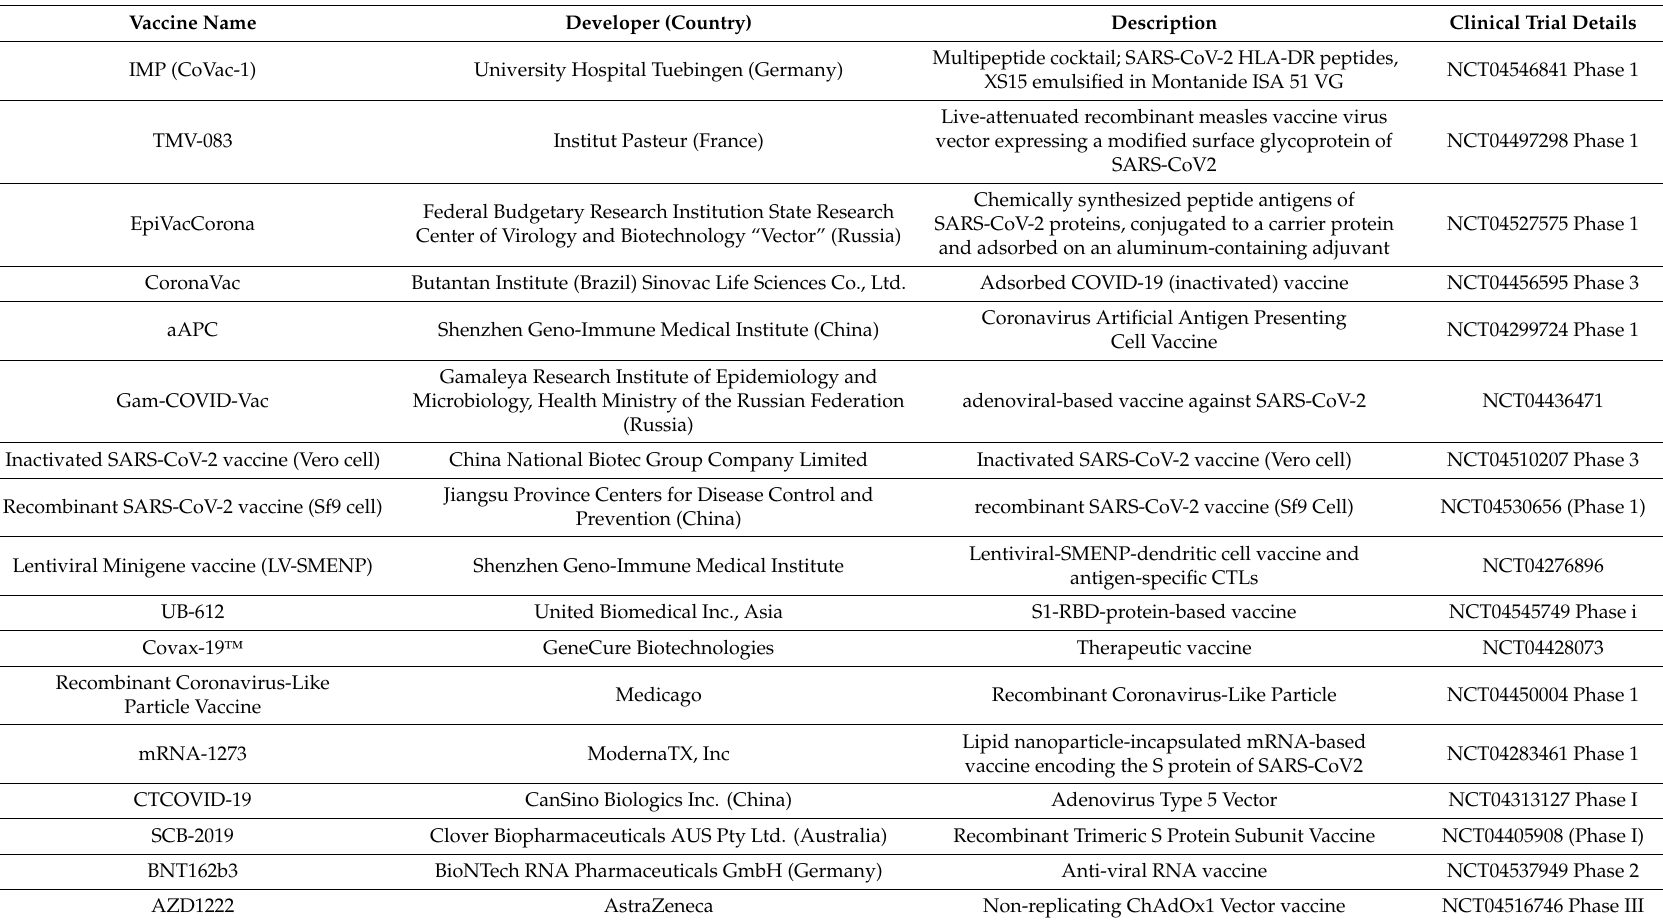
Table 3. SARS-CoV-2 vaccine candidates currently in clinical